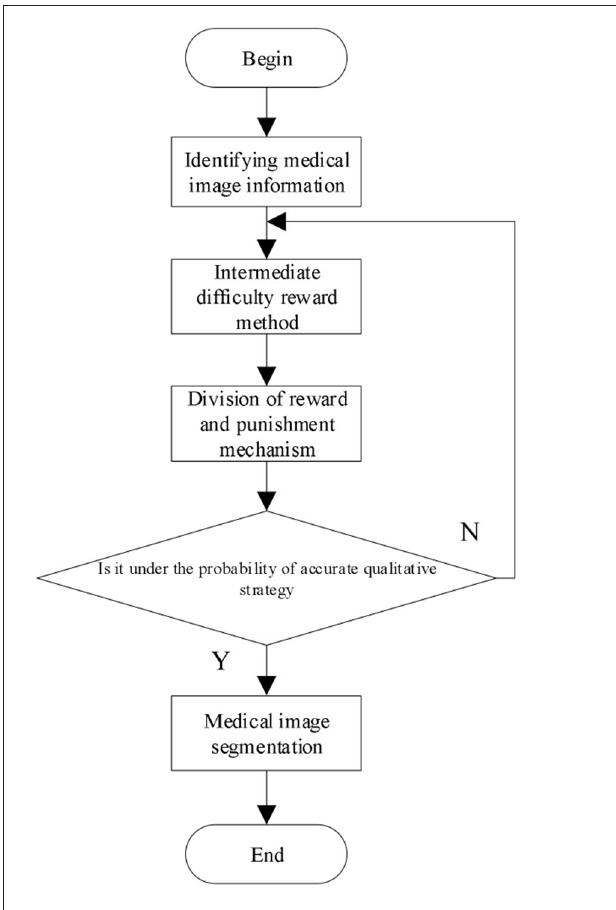
FIGURE 1 | Process of three-dimensional (3D) multimodal medical image